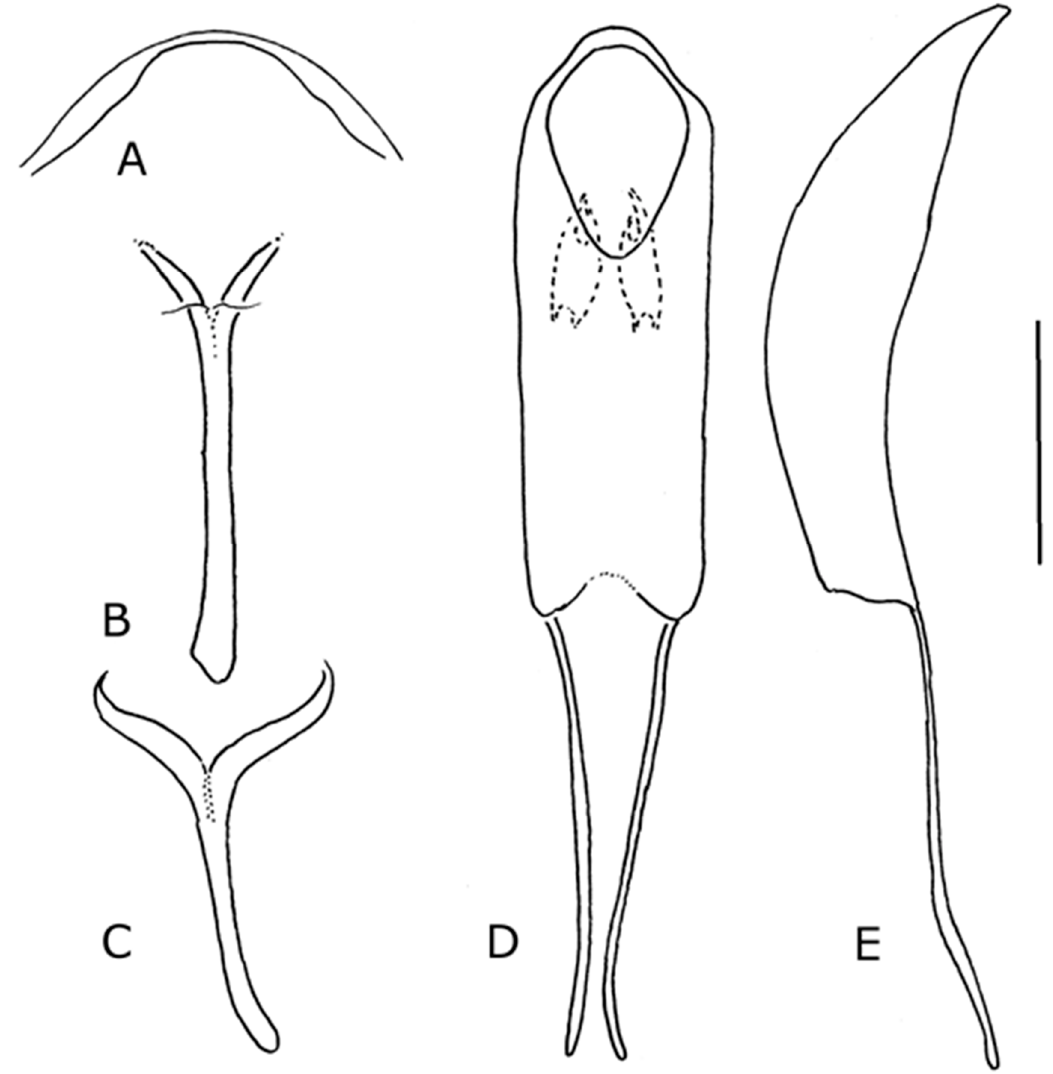
Figure 17. Sclearocardius kuscheli sp.nov. male terminalia: ( A ) sternite VIII, ventral, ( B ) spiculum gastrale, ventral, ( C ) tegmen, dorsal, ( D ) penis, dorsal, and ( E ) penis, lateral. Scale bar = 0.5 mm.